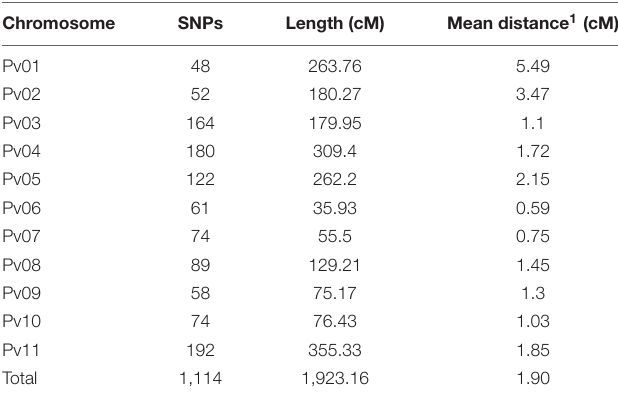
TABLE 2 | Molecular marker distribution, length of each linkage group, and the average distance between the 1,114 markers used to estimate the genetic linkage map for the AM population (AND 277 × IAC-Milênio) through the OneMap package.